Question: According to this chart, does the measure grow or shrink?
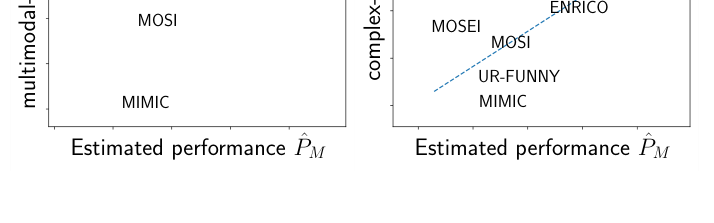
Answer: increasing